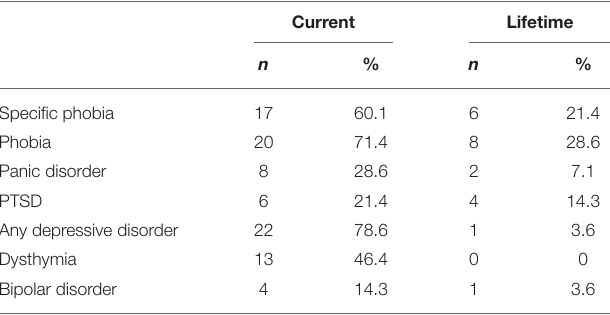
TABLE 2 | Comorbidity table displaying current and lifetime comorbidities of the OCD group in sample